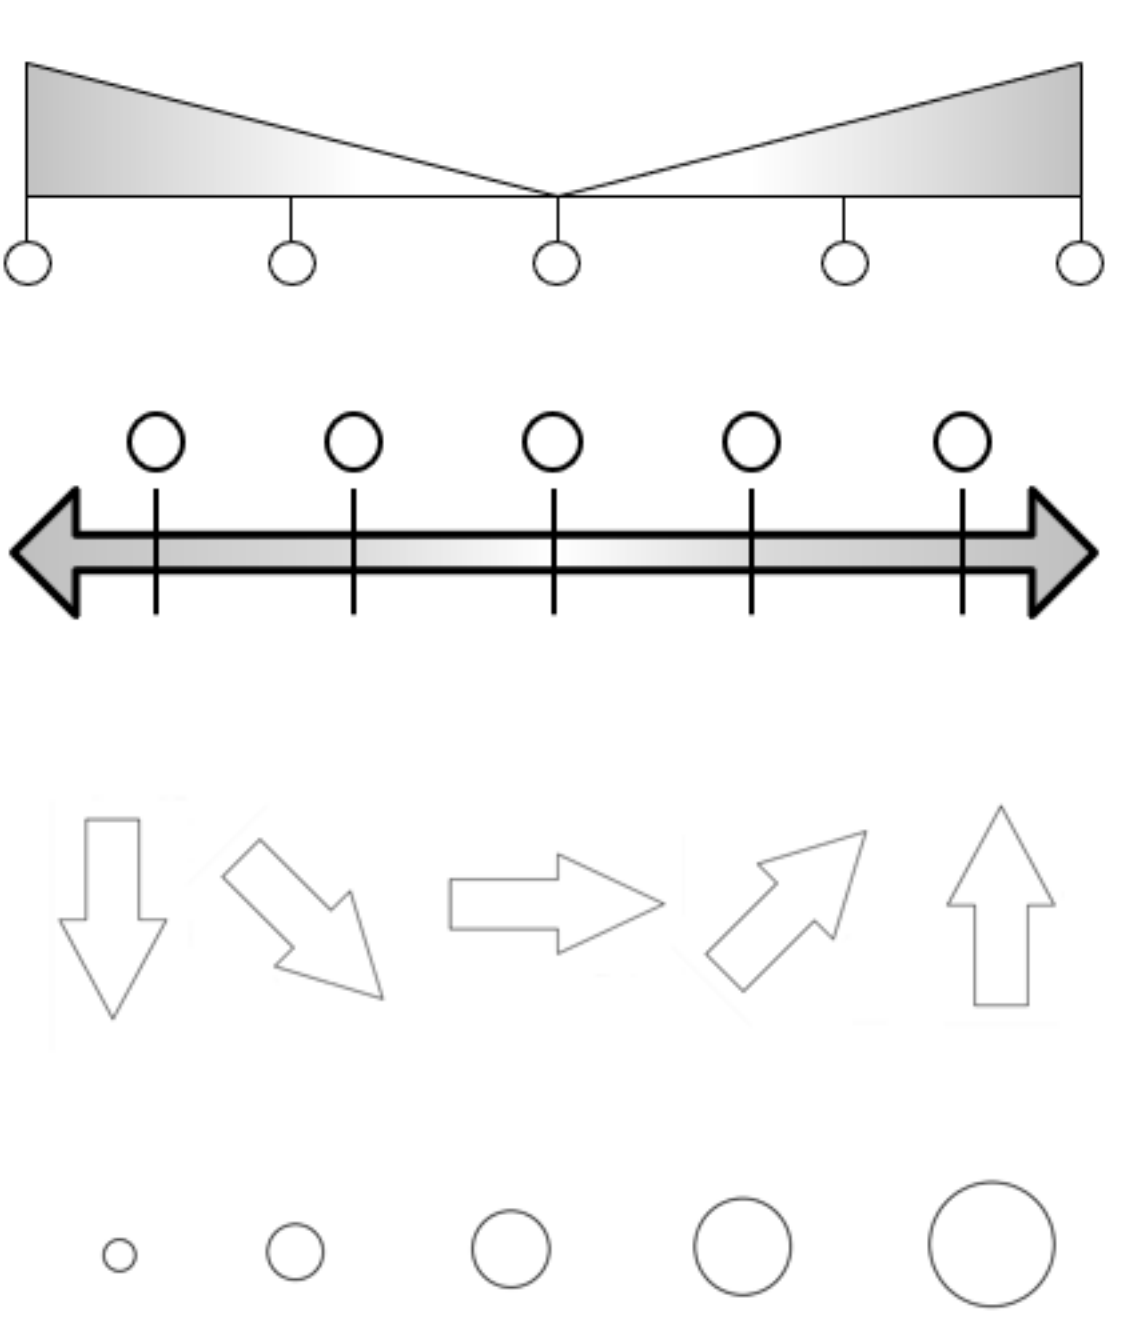
Figure 2. Different types of visual response scales tested during the development of the PictoQOL (Source: own illustration).